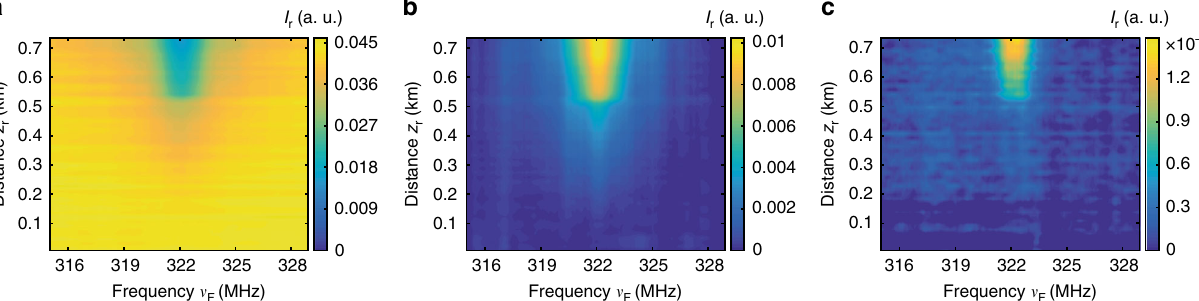
; z Þ of the a 0th, b 1st, and c 2nd order reading pulse sidebands F r